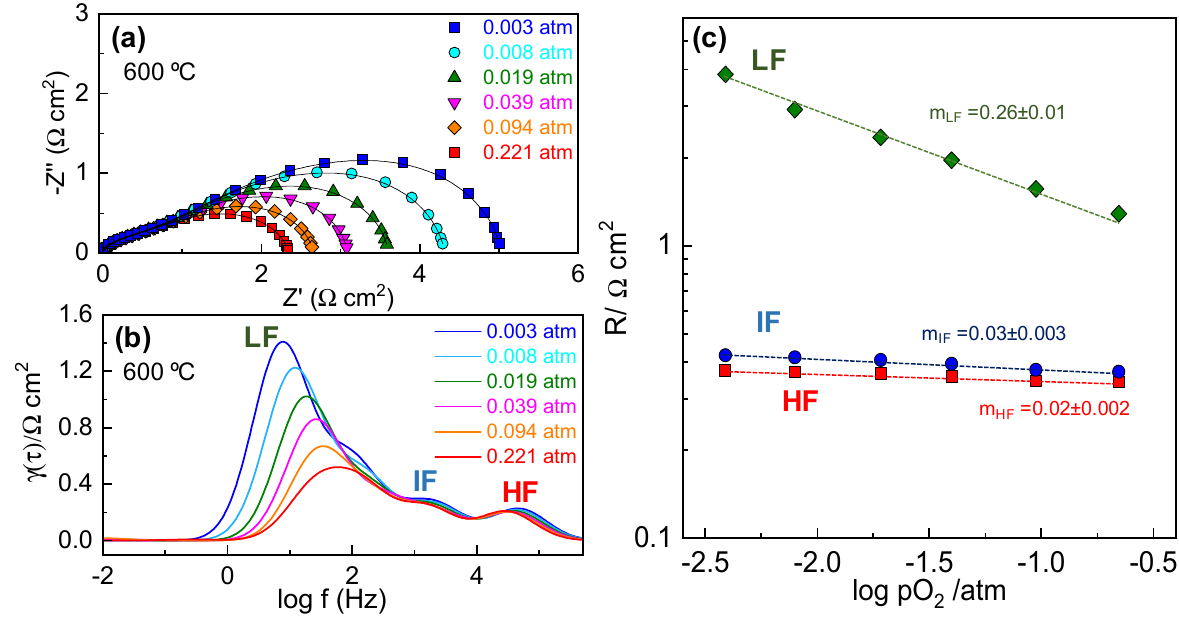
Figure 9. ( a ) Impedance spectra as function of the pO 2 at 600 °C and the corresponding ( b ) distribution of relaxation times analysis of F 0.1 sample. ( c ) Variation in the polarization resistance of the different electrode contributions on pO 2 .